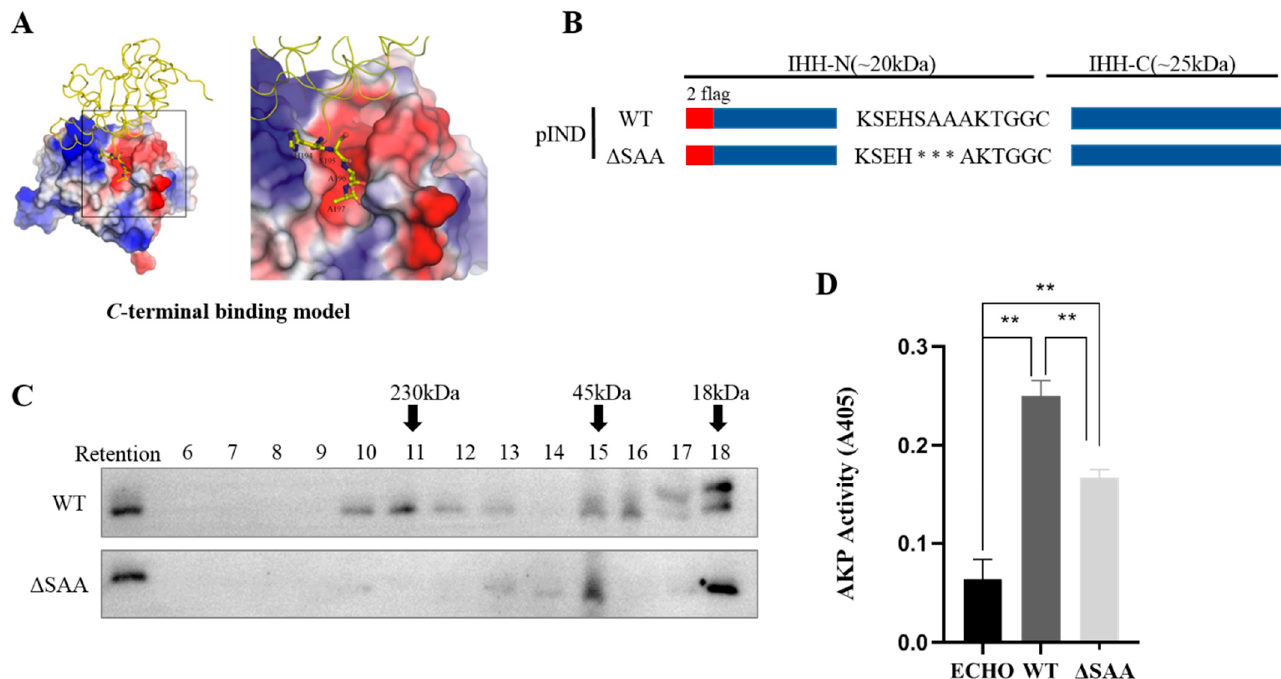
Figure 1. S195, A196, and A197 are required for multimer formation of IHH-N. ( A ) The C -terminal binding model of IHH-N showed that the S195, A196, and A197 of molecule A (pictured as backbone trace) were positioned at the zinc binding site of molecule B (pictured with the molecular surface area coloured by electrostatic potential). ( B ) Schematic of WT and SAA truncation. * truncated amino acids. ( C ) The multimeric form of IHH-N was analysed using gel-filtration chromatography. The retention was the total protein collected in the cell culture supernatants. The amount of multimers in fractions 10–13 in ∆ SAA were significantly reduced compared with that in the WT. ( D ) The results of C3H10T1/2 cell differentiation showed that the AKP activity was significantly impaired in ∆ SAA, suggesting a remarkable attenuation of the IHH signalling activity. Data are mean ± s.e.m, n = 3, ** p < 0.01.